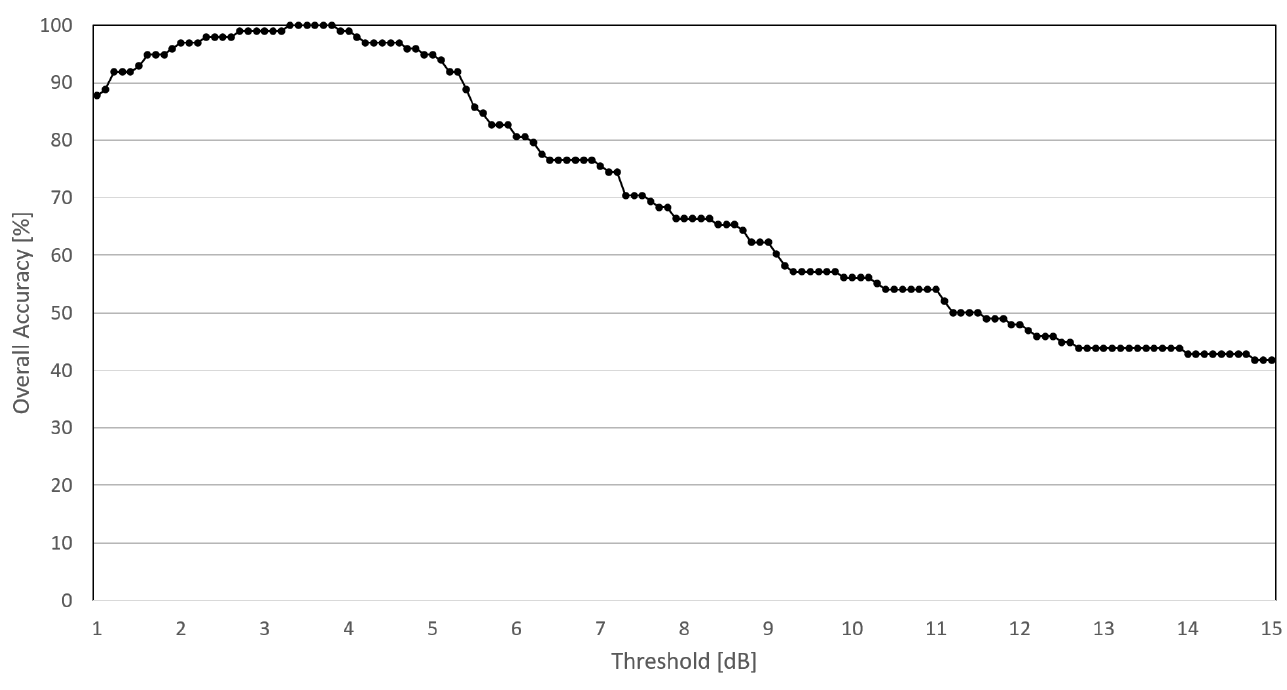
Figure 10. Overall Accuracy as function of the distance threshold d thrs . A connecting line is added between points to increase